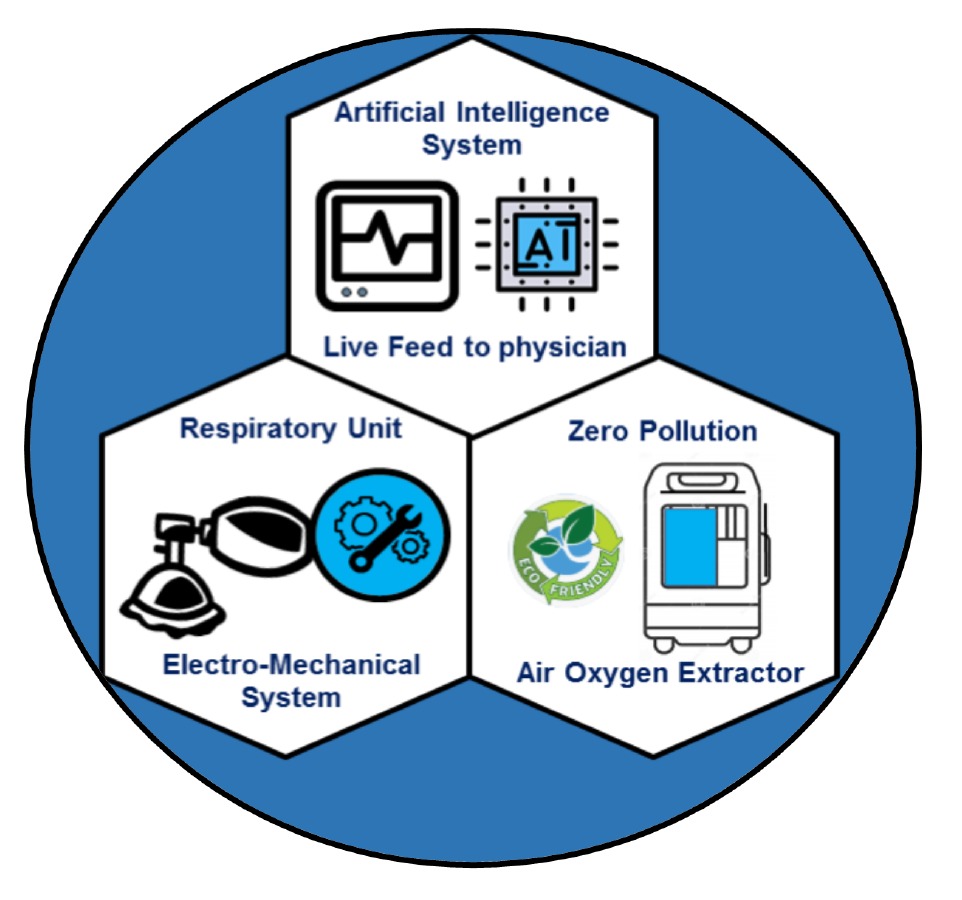
Figure 3. Schematic of the core components of the